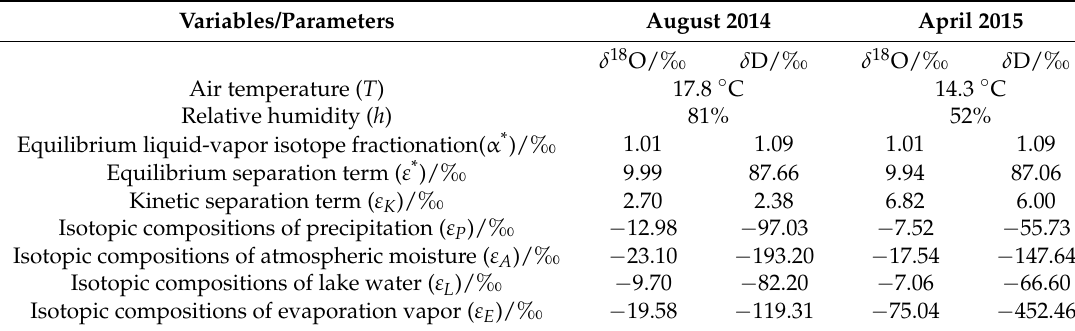
Table 4. Variables and parameters used in the calculation of isotopic compositions of evaporation vapor during the study